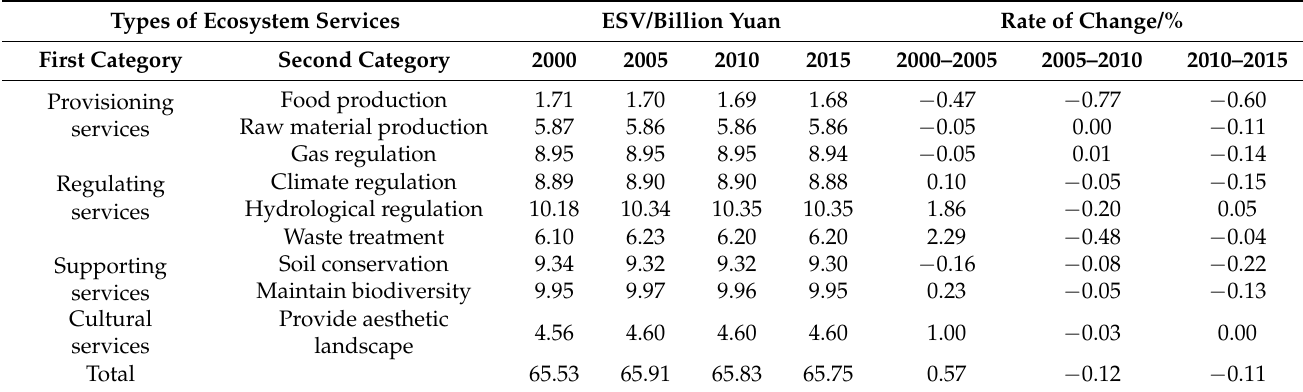
Table 4. Changes in the structure of the ESV in the Funiu Mountain area from 2000 to